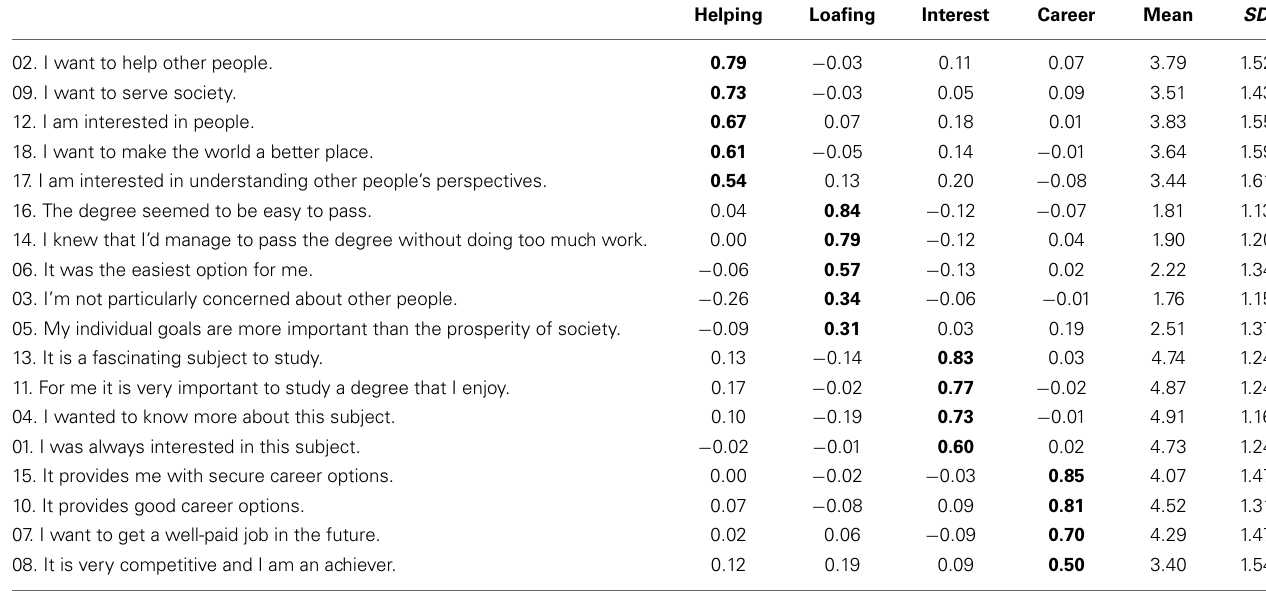
Table 1 | Descriptive statistics for the final version of the MICC scales (Sample 1, undergraduate